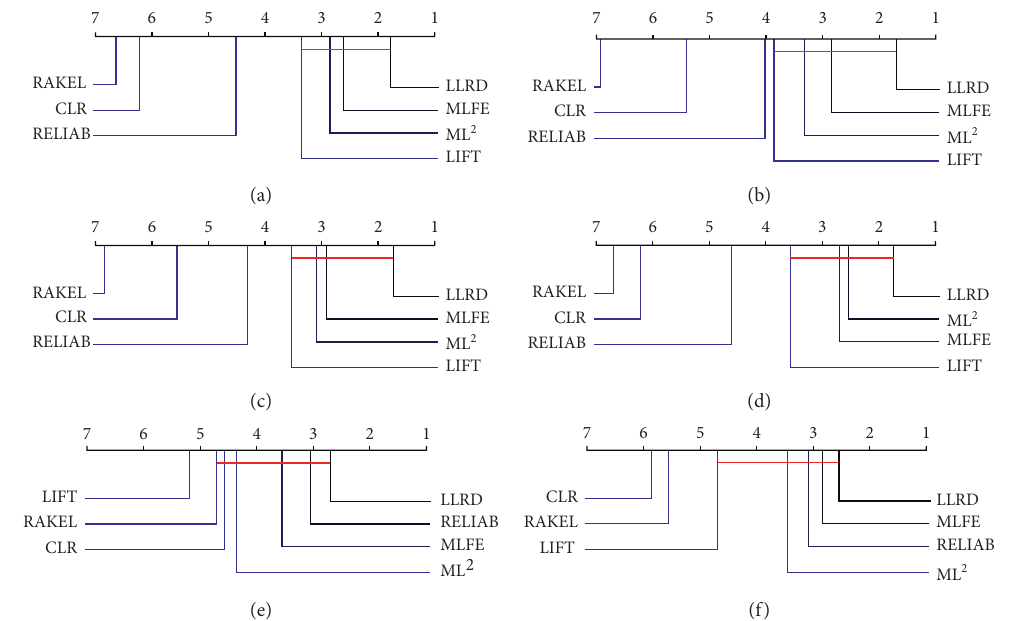
Figure 1: Comparison of LLRD (control algorithm) against other related approaches with the Bonferroni–Dunn test. Approaches that are not connected to LLRD are significantly different in performance from LLRD. (a) One-error. (b) Coverage. (c) Ranking loss. (d) Average precision. (e) Macroaveraging F 1. (f) Microaveraging F